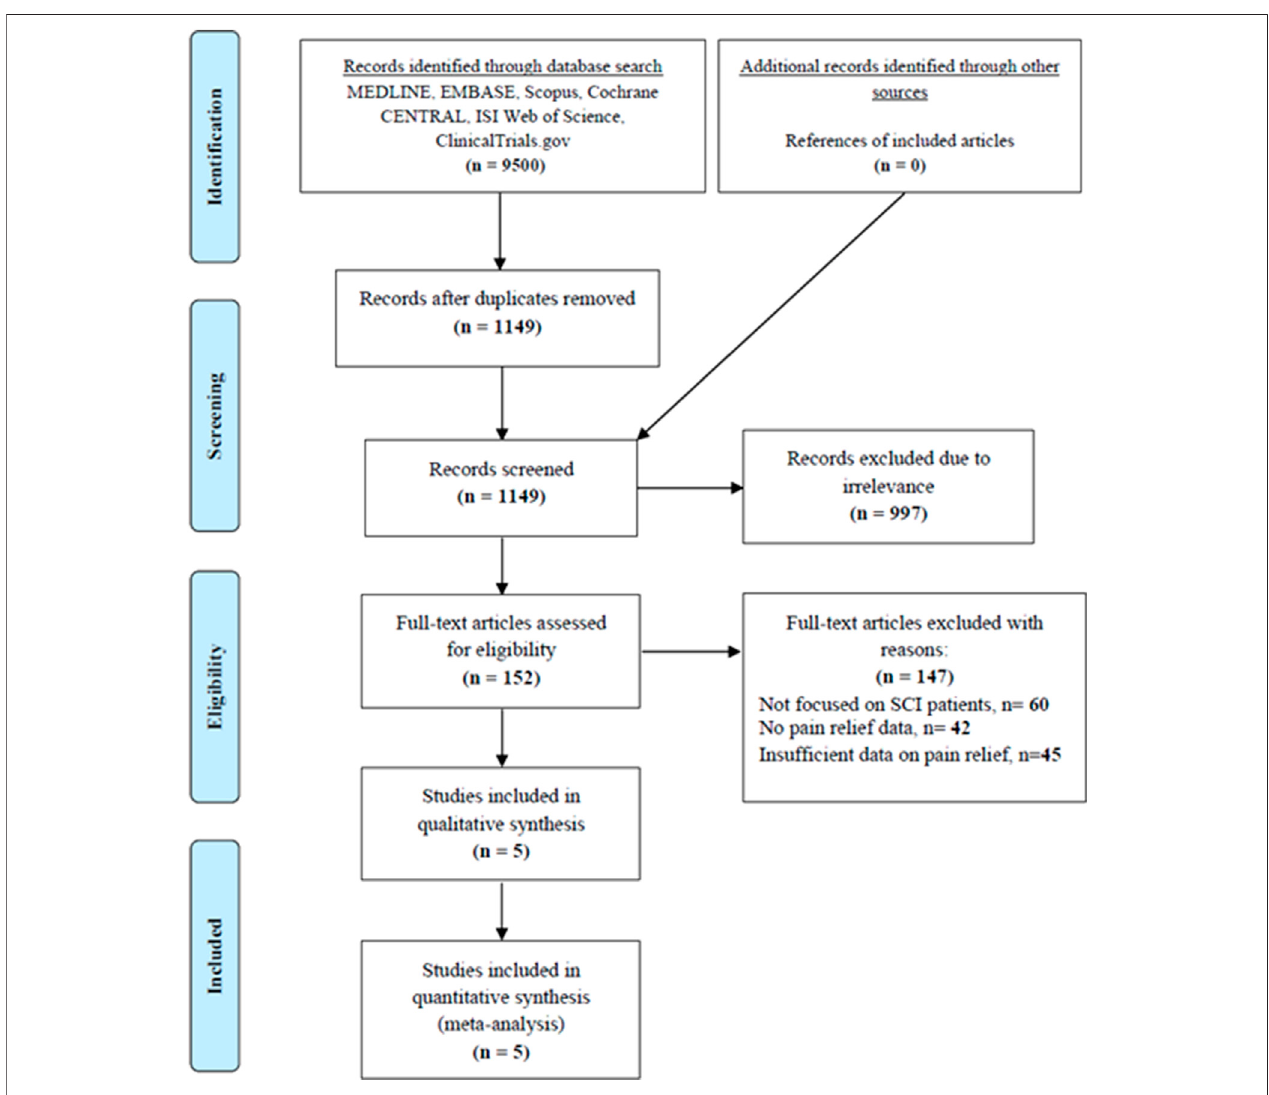
FIGURE 1 | Flow diagram of identi fi cation, screening, eligibility, and